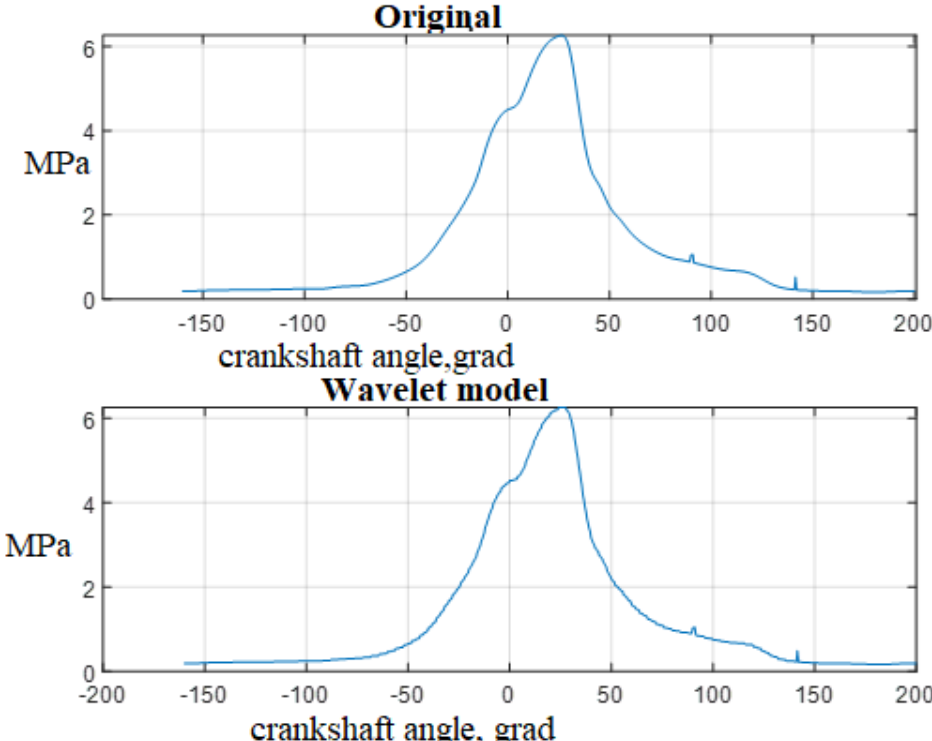
Figure 4. Pressure in the cylinder of a marine internal combustion engine: original and wavelet model.